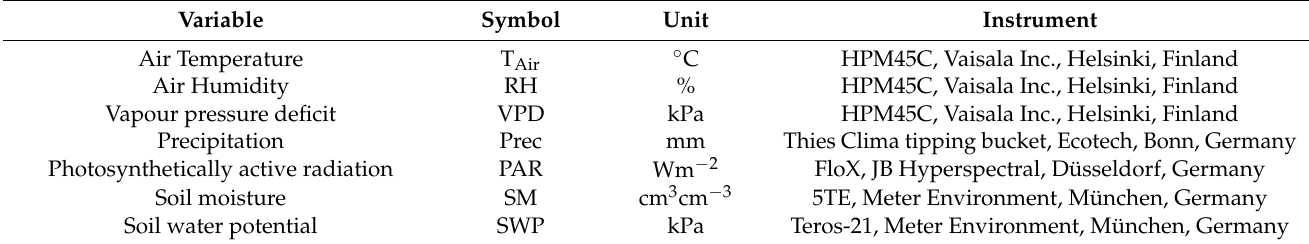
Table 1. Overview of equipment used during the measurement